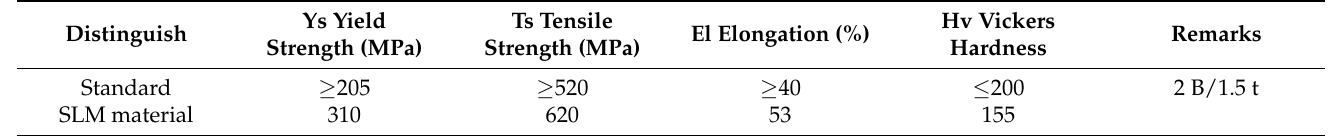
Table 2. Mechanical properties of 316L stainless steel (JIS G 4305-2005).